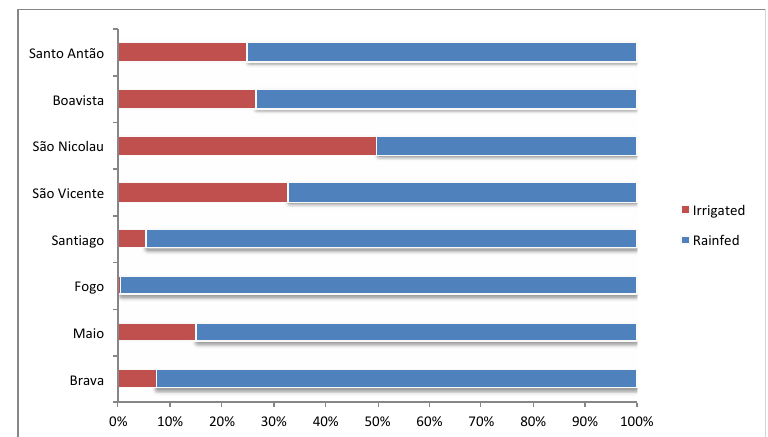
Figure 2. Rainfed and irrigated agriculture areas in Cabo Verde Islands.